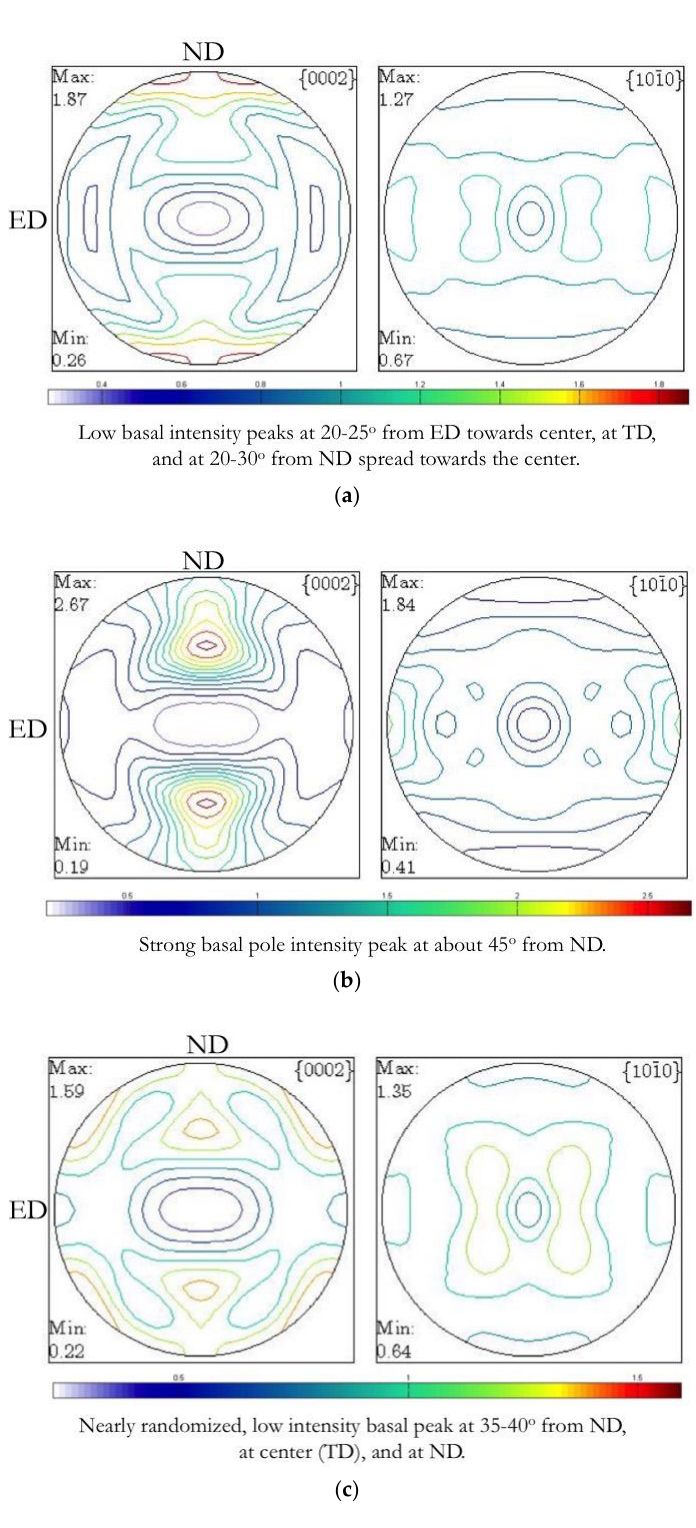
Figure 9. XRD pole figures of the ED specimens deformed at three peak-efficiency conditions of the three domains corresponding to the ED processing map. ED (the compression axis) is along the horizontal axis and ND is vertical. ( a ) 300 °C and 0.0003 s −1 (Domain 1); ( b ) 500 °C and 0.0003 s −1 (Domain 2); ( c ) 450 °C and 10 s −1 (Domain 3).